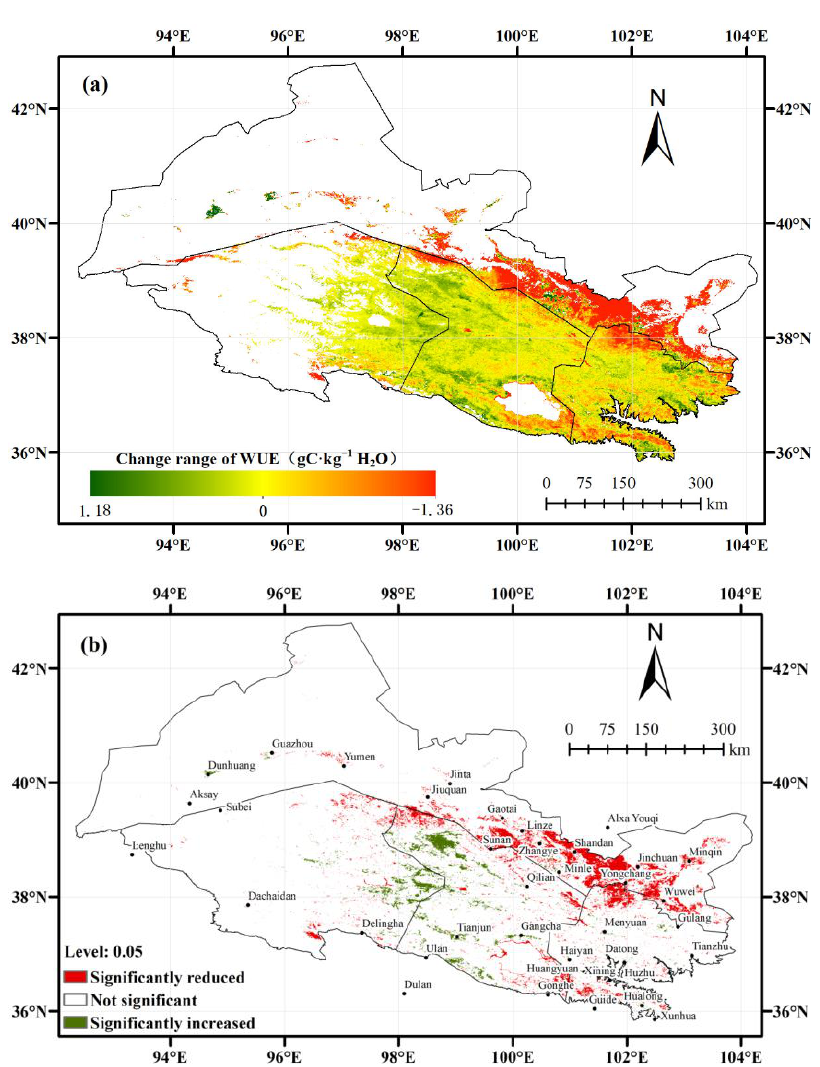
Figure 8. Spatial distribution of the magnitude of WUE change ( a ) and M-K test result ( b ).